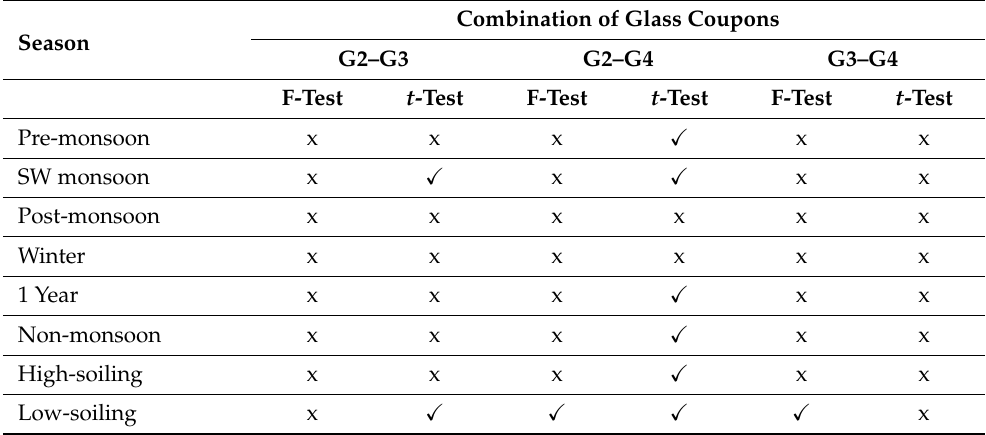
Table 2. The F-test and t -test statistical analysis comparing the weekly cleaned (G2), monthly cleaned (G3), and never cleaned (G4) glass coupons. This represents the topmost rectangle for the data collection and methodology section in the flowchart of Figure